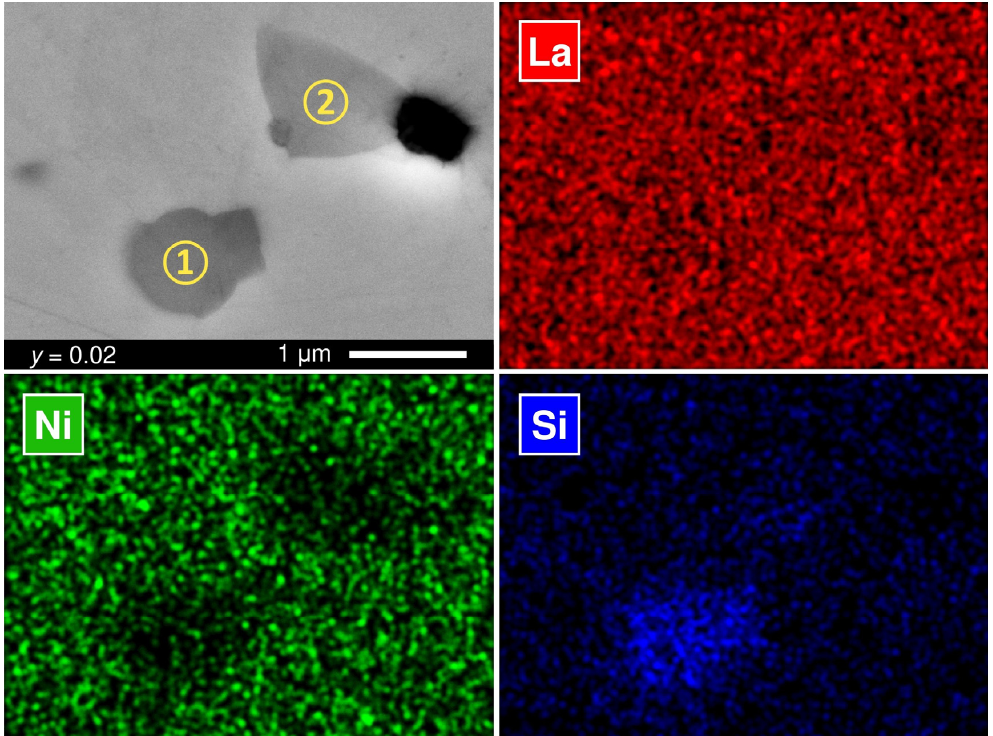
Figure 4. SEM image of the polished surface of La 2 Ni 0.98 Si 0.02 O 4+ δ ceramics and corresponding EDS elemental maps. Spots 1 and 2 correspond to La 2 − x Si 6 O 26+ δ and La 2 O 3 impurity phase inclusions, respectively.